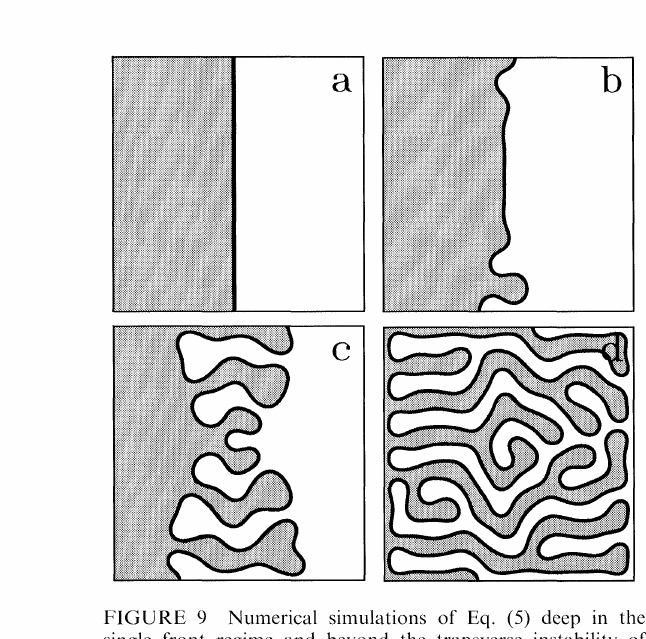
FIGURE 9 Numerical simulations of Eq. (5) deep in the single front regime and beyond the transverse instability of that front. Like in the chemical experiment (Fig. 1), the trans- verse instability leads eventually to a stationary